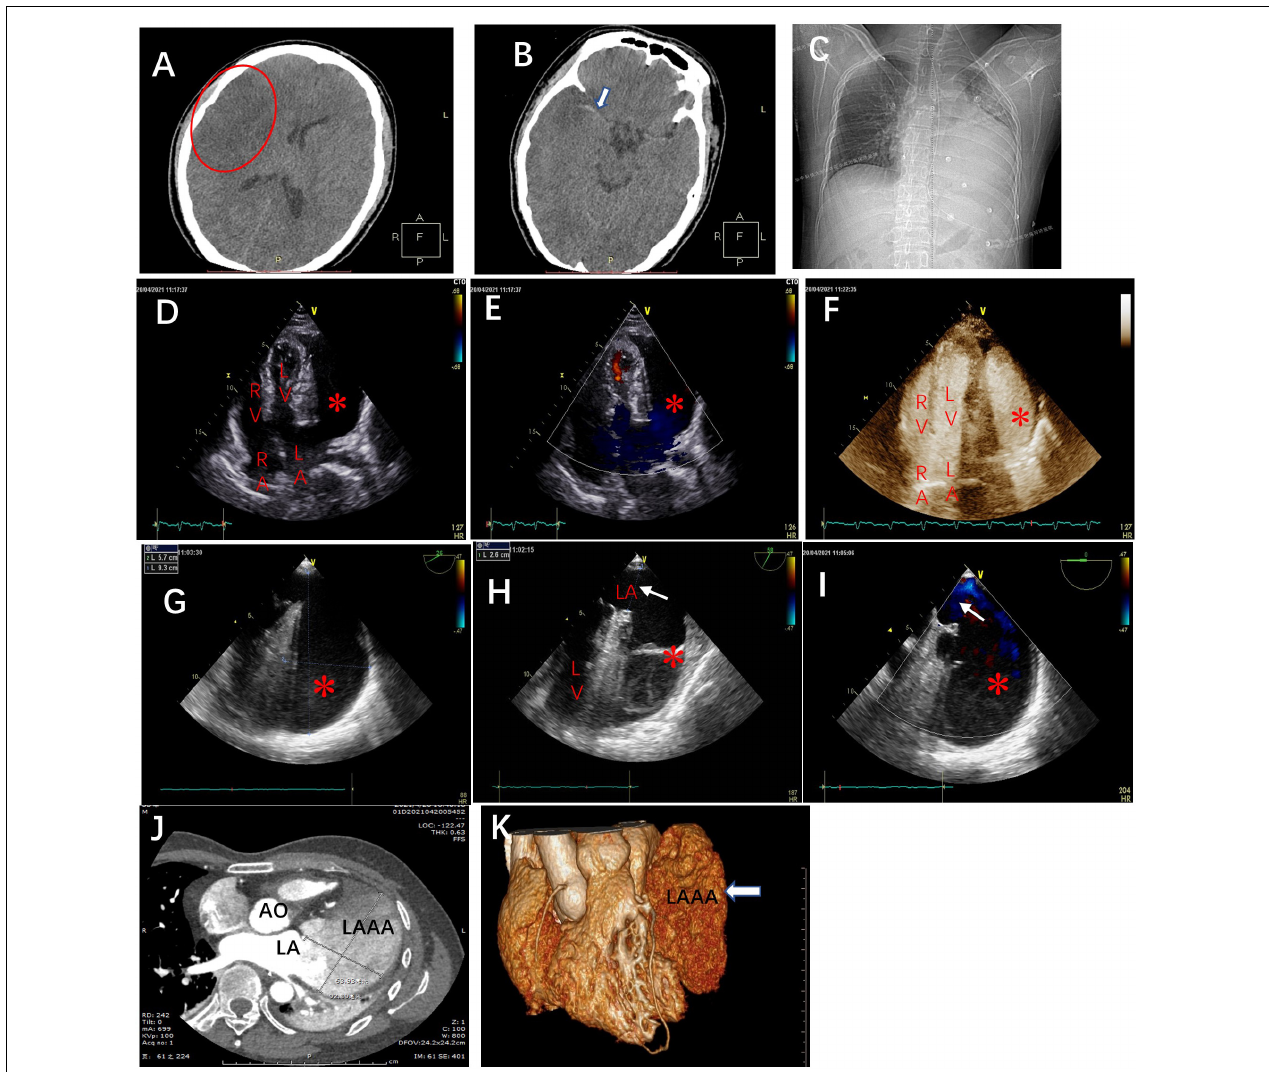
FIGURE 2 | The brain computed tomography scans at admission revealed (A) massive cerebral infarction in the right-sided frontotemporal insula (red circle) and (B) the basal ganglia area with right middle cerebral artery thrombus (white arrow). (C) The chest X-ray in the cardiology department demonstrating the abnormal left heart border. Transthoracic echocardiography (TTE), apical four-chamber view (D) , and the view with color doppler (E) revealing an echo-free cavity (red star) adjacent to and compressing the LV and the probable communication of the cavity with the LA; TTE with contrast showing the contrast filling in the LA and the cavity simultaneously without filling defect in the cavity (F) ; TEE, the mid-esophageal 2-chamber and LAA view demonstrating a giant cavity (red star) measuring 9.3 cm × 5.7 cm (G) and its connection to LA via a 2.6 cm-wide orifice (white arrow) (H) and the to-and-fro blood flows between LA and the cavity (red star) through the orifice (white arrow) (I) . Axial computed tomography scan (J) and 3D reconstruction (K) demonstrate a 9.3 cm × 6.4 cm × 3.8 cm giant LAAA. AO: aorta; RA: right atrium; LA: left atrium; RV: right ventricle; LV: left